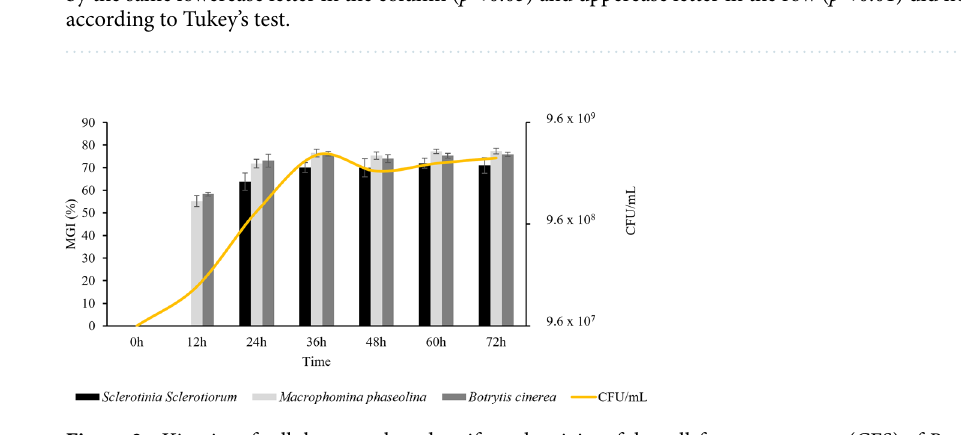
Figure 3. Kinetics of cellular growth and antifungal activity of the cell-free supernatant (CFS) of Bacillus velezensis CMRP 4489. Mycelial Growth Inhibition percentage (MGI%); Colony Forming Units per milliliter